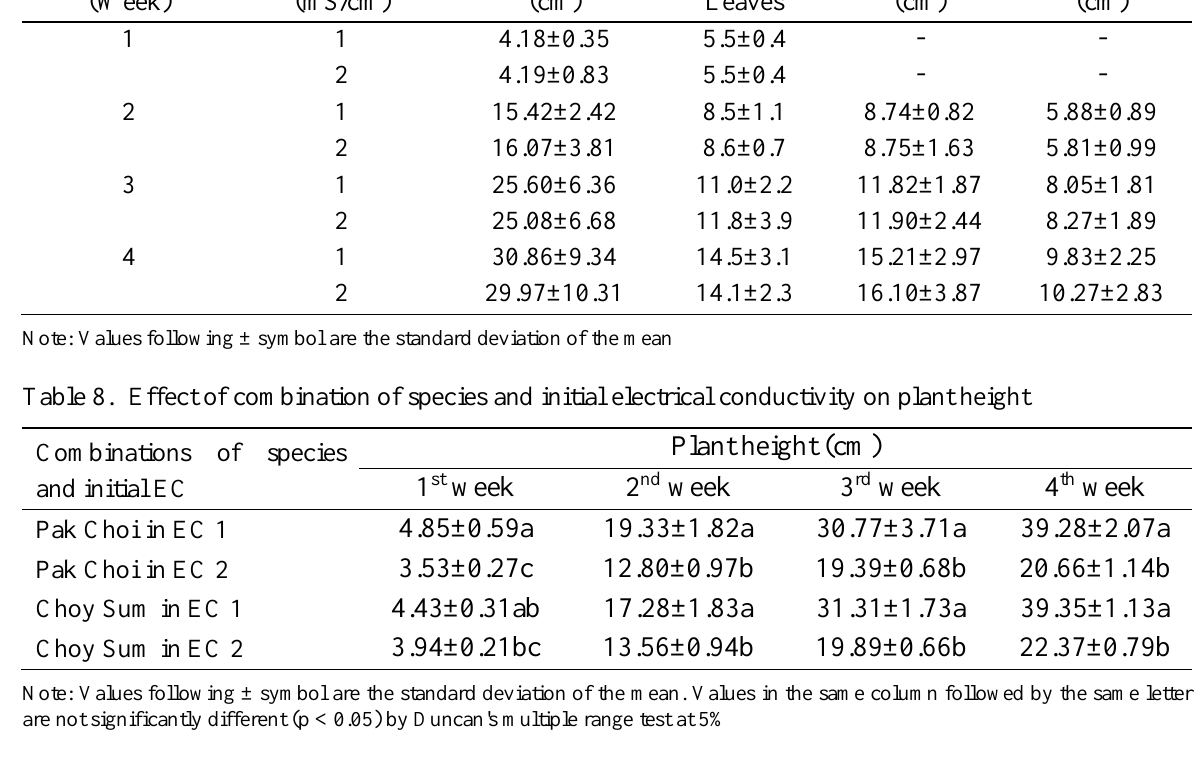
Table 9. Effect of combination of species and initial electrical conductivity on number of leaves Combinations of